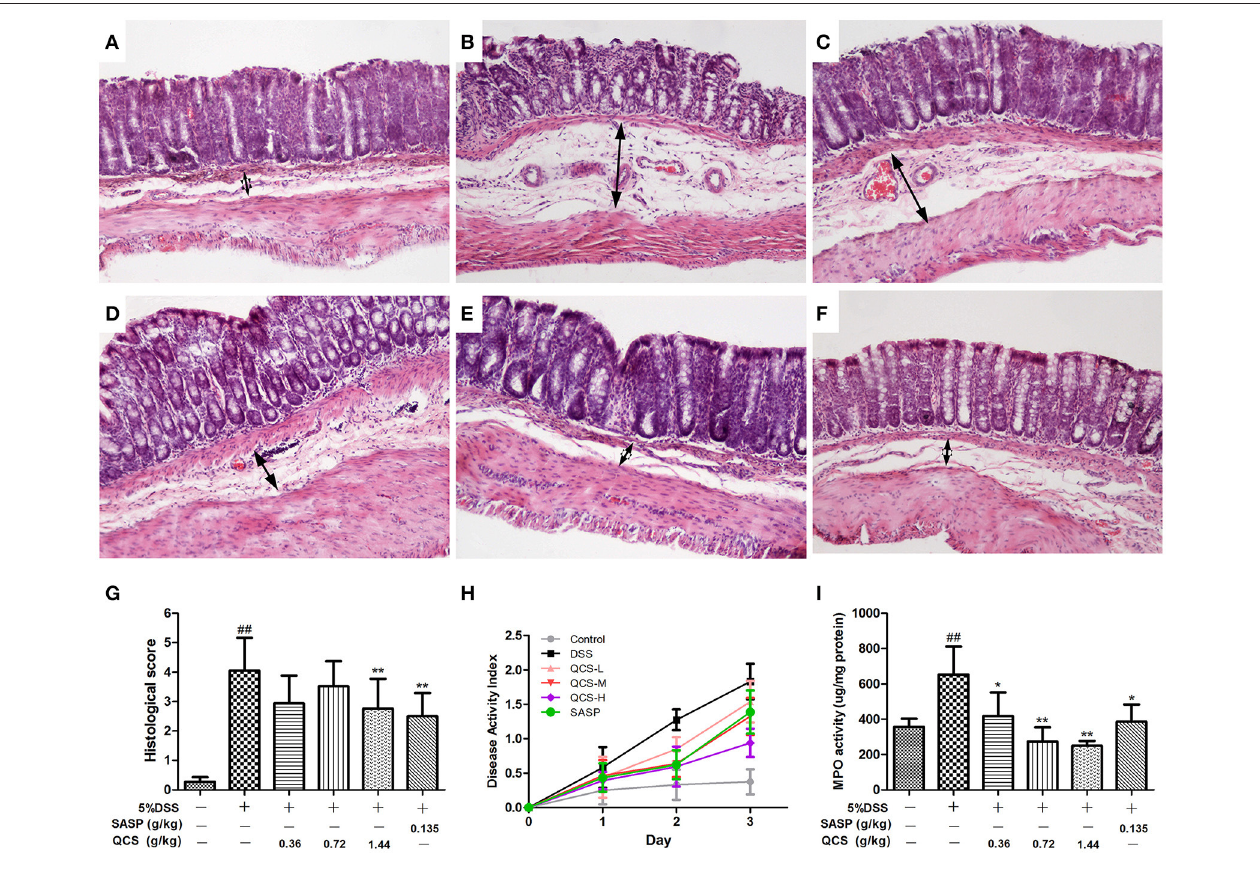
FIGURE 4 | Effects of QCS on histopathological changes, DAI and MPO activity in colon of rats with DSS-induced colitis. (A) Control; (B) DSS model; (C) QCS 0.36 g/kg; (D) QCS 0.72 g/kg; (E) QCS 1.44 g/kg; (F) SASP 0.135 g/kg; (HandE staining, × 100); (G) histological score; and (H) The disease activity index (DAI) was determined by combining scores of body weight loss, stool consistency, and occult blood, The final result was expressed as the average of the three. (I) MPO activity. DSS administration was performed in all groups except the control group. QCS and SASP were administered to rats each day after DSS treatment. All rats were killed on day 3 after DSS administration, three sections from each animal tissue were scored, colonic tissue damage was evaluated by histopathological analysis (HandE staining). MPO activity in colonic tissue was determined. Data were expressed as mean ± SD ( n = 8), * P < 0.05, ** P < 0.01 vs. model group; ## P < 0.01, vs. control